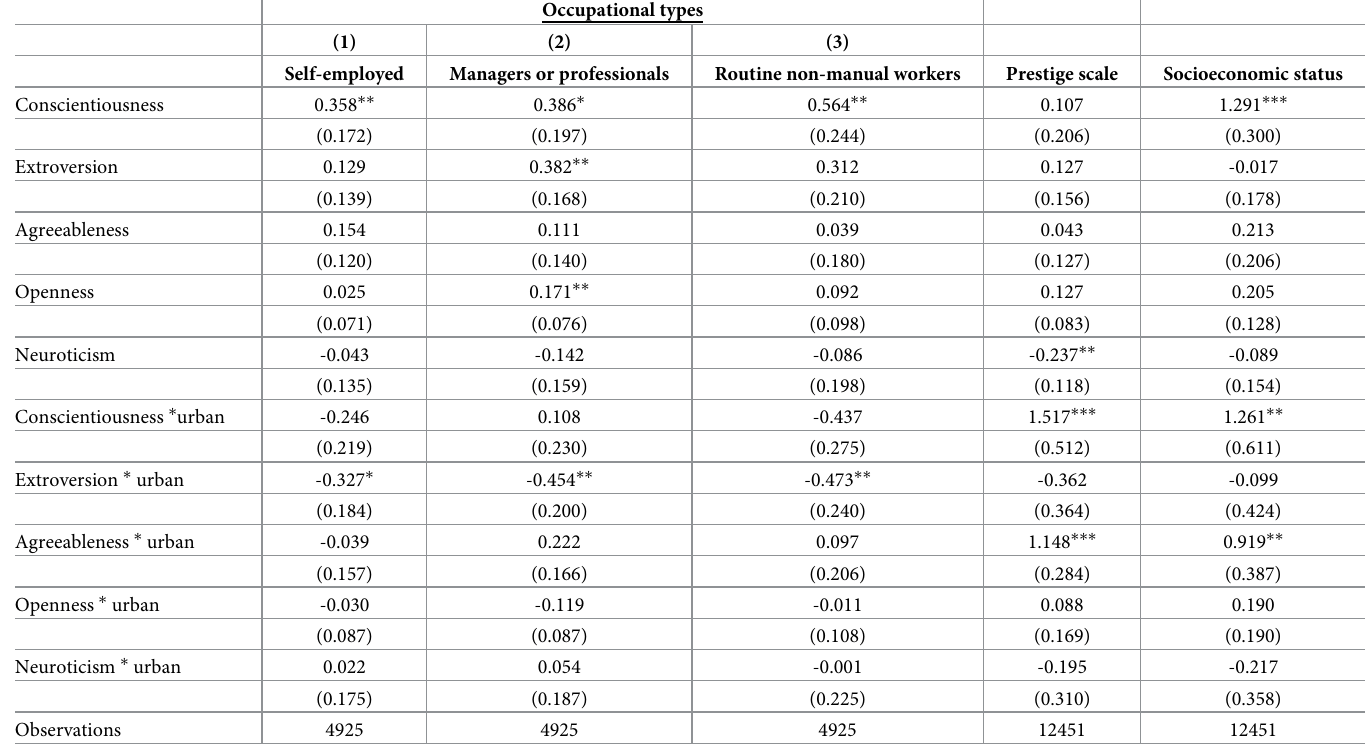
Table 8. Heterogeneity in terms of urban or rural